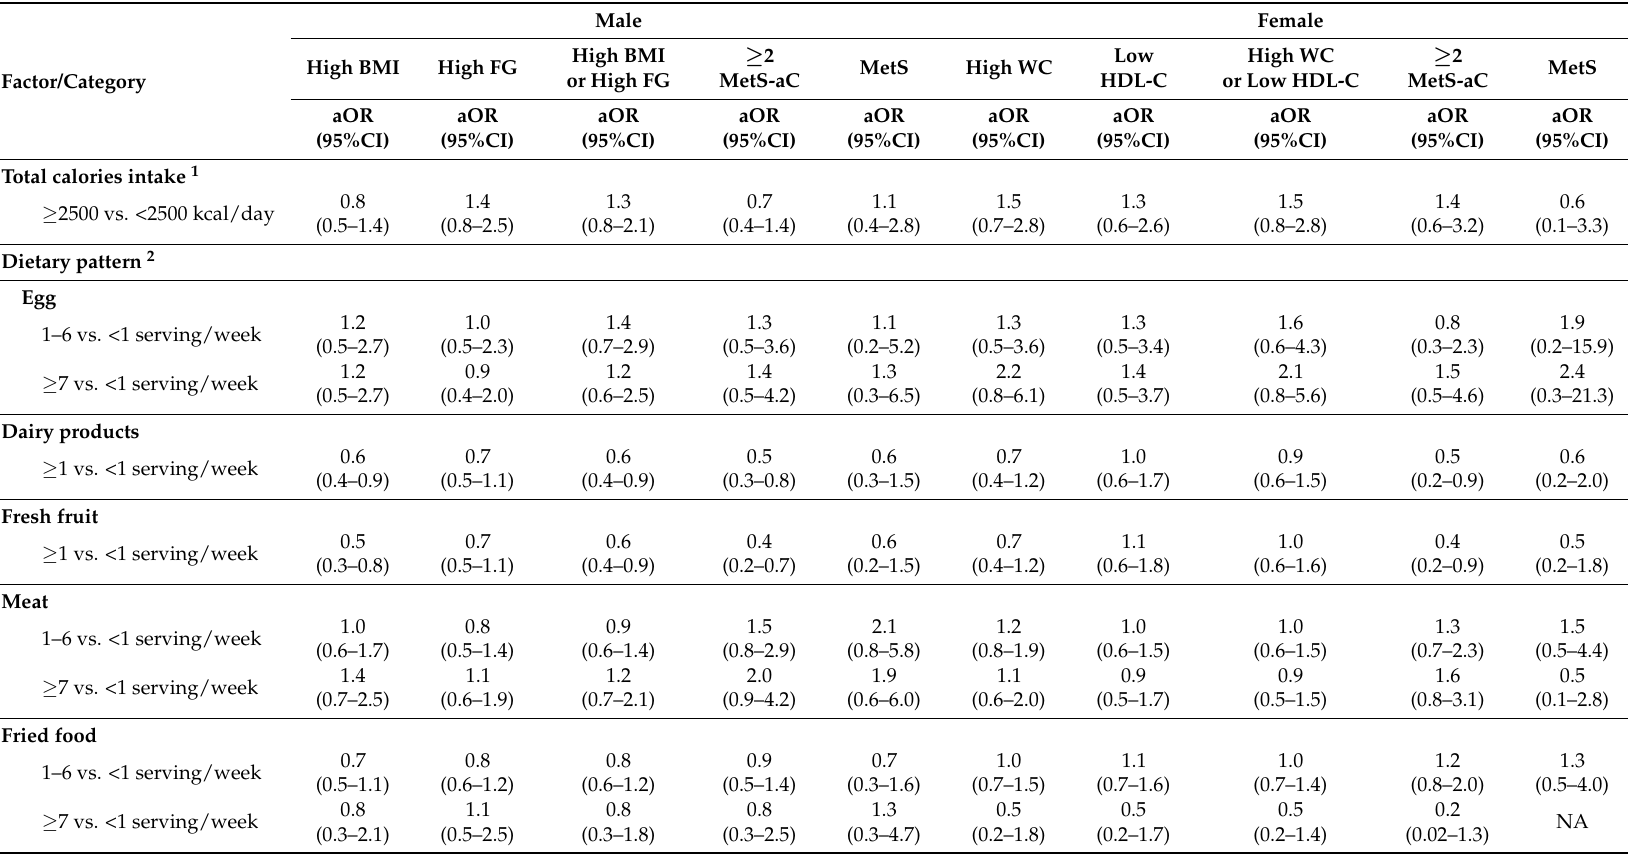
Table 4. Adjusted odds ratio (aOR) of the clustering of MetS risk components associated with the dietary pattern in adolescents,